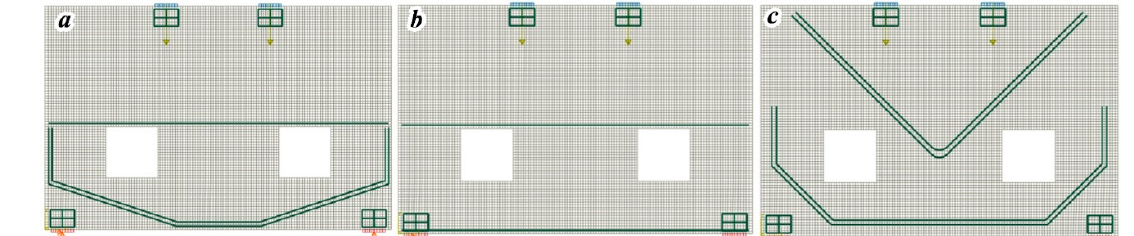
Figure 16. Model FEM A of the reinforced concrete walls: ( a ) W1, ( b ) W2, and ( c ) W3.